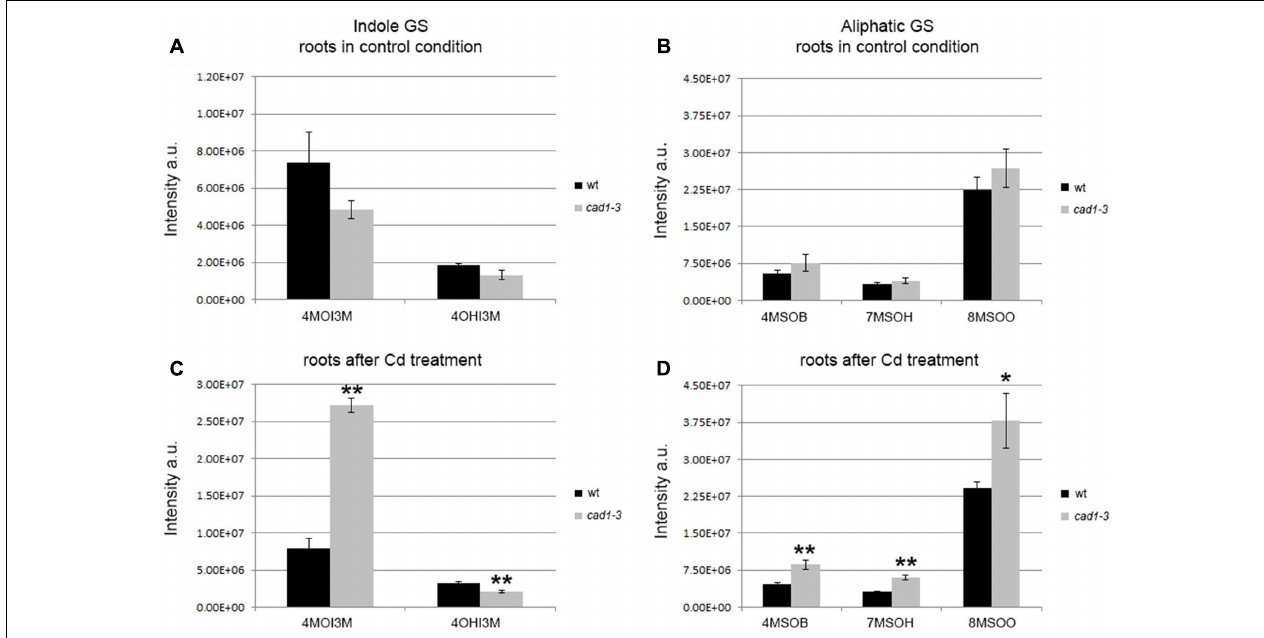
FIGURE 2 | Levels of indole and aliphatic glucosinolates in roots from wt and cad1-3 plants, grown under control conditions (A,B) or exposed to 36 µ M CdCl 2 for 24 h (C,D) . 4OHI3M, 4-hydroxy-indolyl-3-methylglucosinolate; other glucosinolate abbreviations and statistics as in Figure 1